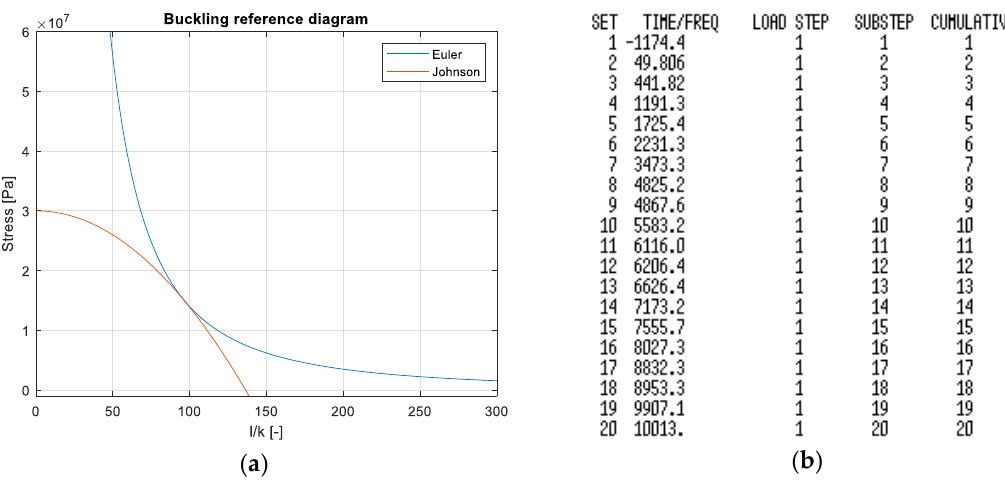
Figure 5. ( a ) Buckling reference diagram; ( b ) Eigenvalues of the buckling analysis performed on Ansys ® .